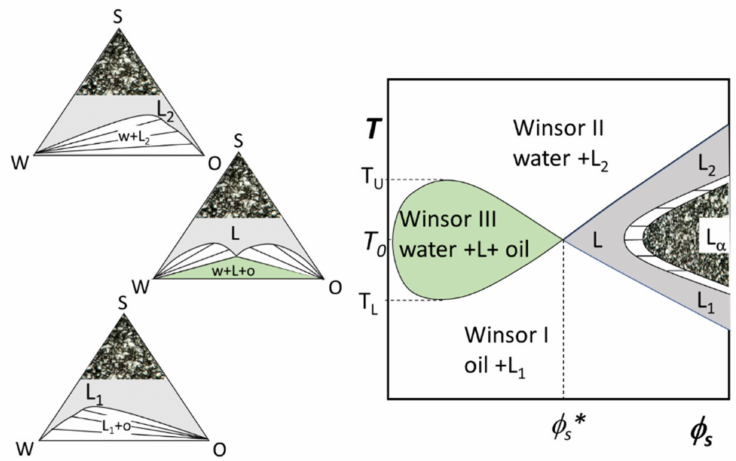
Figure 7. On the right, schematic bidimensional Kahlweit’s “fish-plot” phase-diagram at φ w = φ o for ethoxylate-based ternary microemulsion around the balance temperature T 0 . One-phase µ E (in gray) is found only above φ s * in a region with the shape of a fish-tail. The fish-shaped body (in green) contains three-phase systems (Winsor III). L α denotes a lamellar liquid crystalline phase. On the left side, three corresponding isothermal phase diagrams are reported. From bottom to top: T < T 0 , T = T 0 , T > T 0 . Speculatively, for T < T L the interfacial curvature is highly bent toward oil and a Winsor I two-phase equilibrium takes place (sometimes denoted as